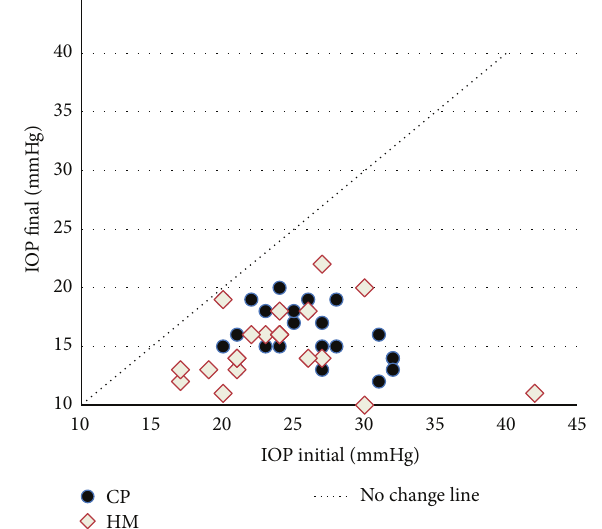
Figure 1: Scatterplot of preoperative (IOP initial) versus postop- erative (IOP final) IOP values in the two treatment groups (CP = canaloplasty group; HM = Hydrus Microstent group).